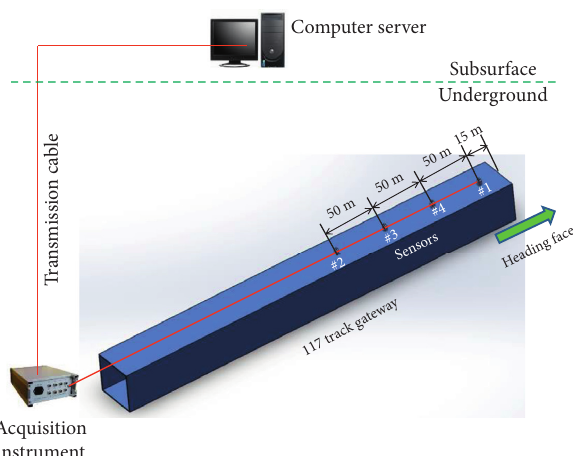
Figure 1: MS system installed in 117 track gateway.